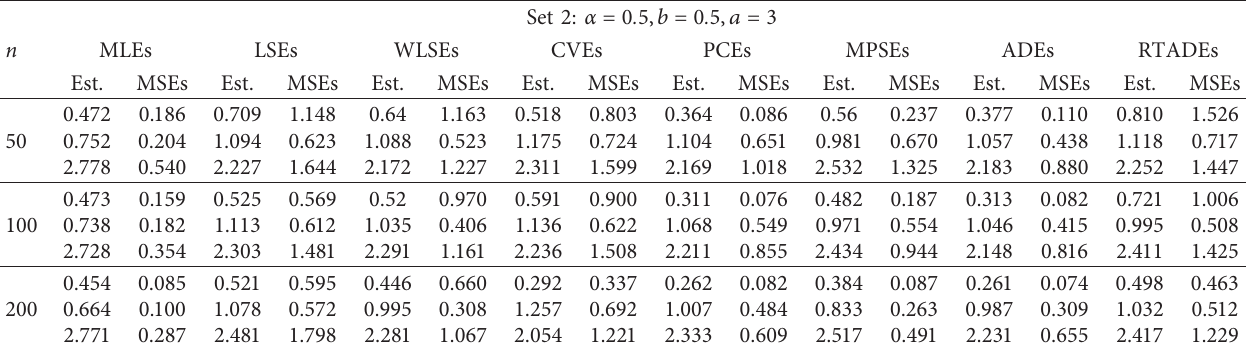
Table 3: Estimates and MSEs of APTIL distribution for ML, LS, WLS, CV, PC, MPS, AD, and RTAD estimates for set 3. n